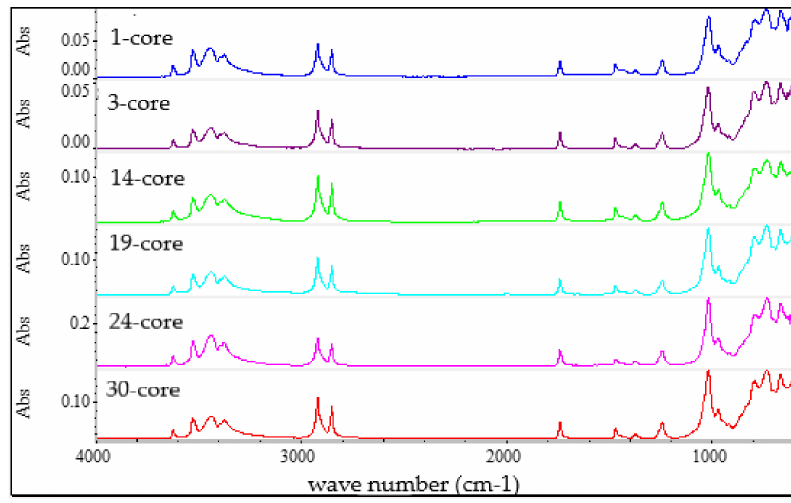
Figure 6. FTIR spectra of the outer sheath of the tested